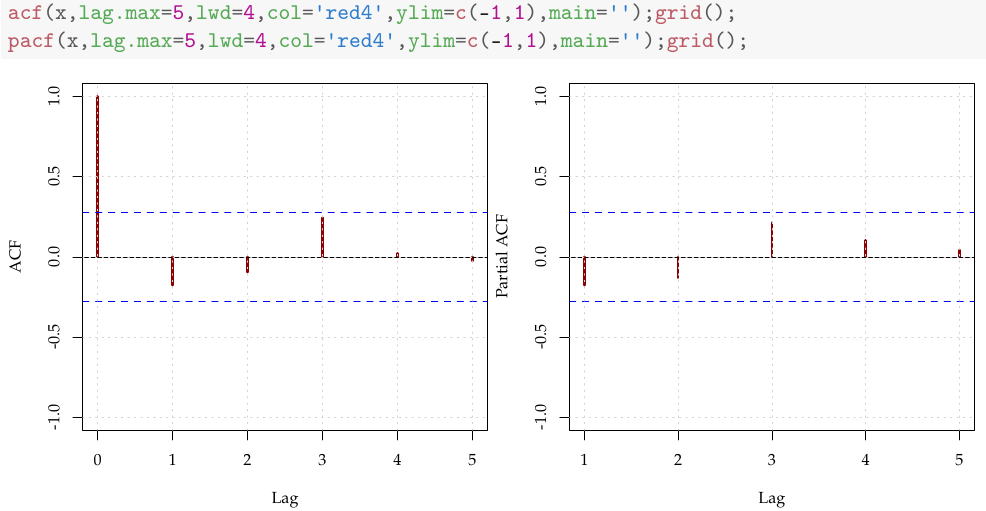
Figure 12. Correlograms computed on a realization of a nonlinear MA